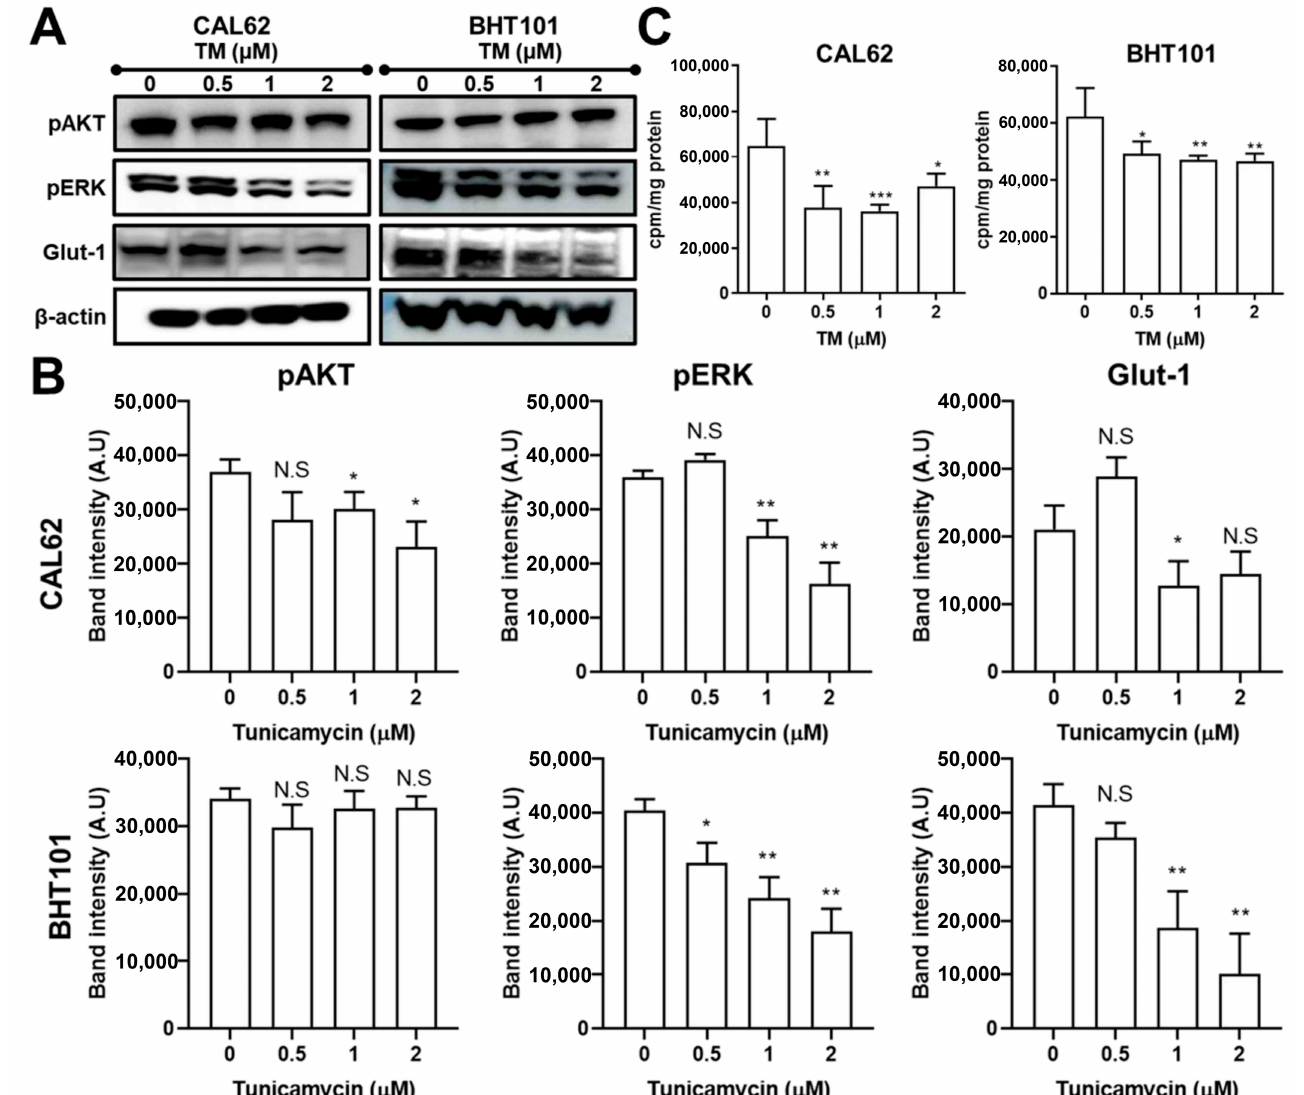
Figure 4. Inhibition of the MAPK pathway and glucose metabolism by tunicamycin (TM). ( A , B ) Immunoblotting analysis of AKT and ERK phosphorylation levels and Glut1 protein level in CAL62 and BHT101 cells treated with 2 µ M TM at 24 h post- treatment. Quantitative analysis of pAKT, pERK, and Glut1 levels by scanning densitometry. ( C ) 18 F-fluorodeoxyglucose (FDG) uptake levels in TM-treated CAL62 and BHT101 cells at 24 h post-treatment. CPM, count per minute. * p < 0.05, ** p < 0.005, and *** p < 0.0005 compared to absence of TM. Data are the mean ± SD of three samples per